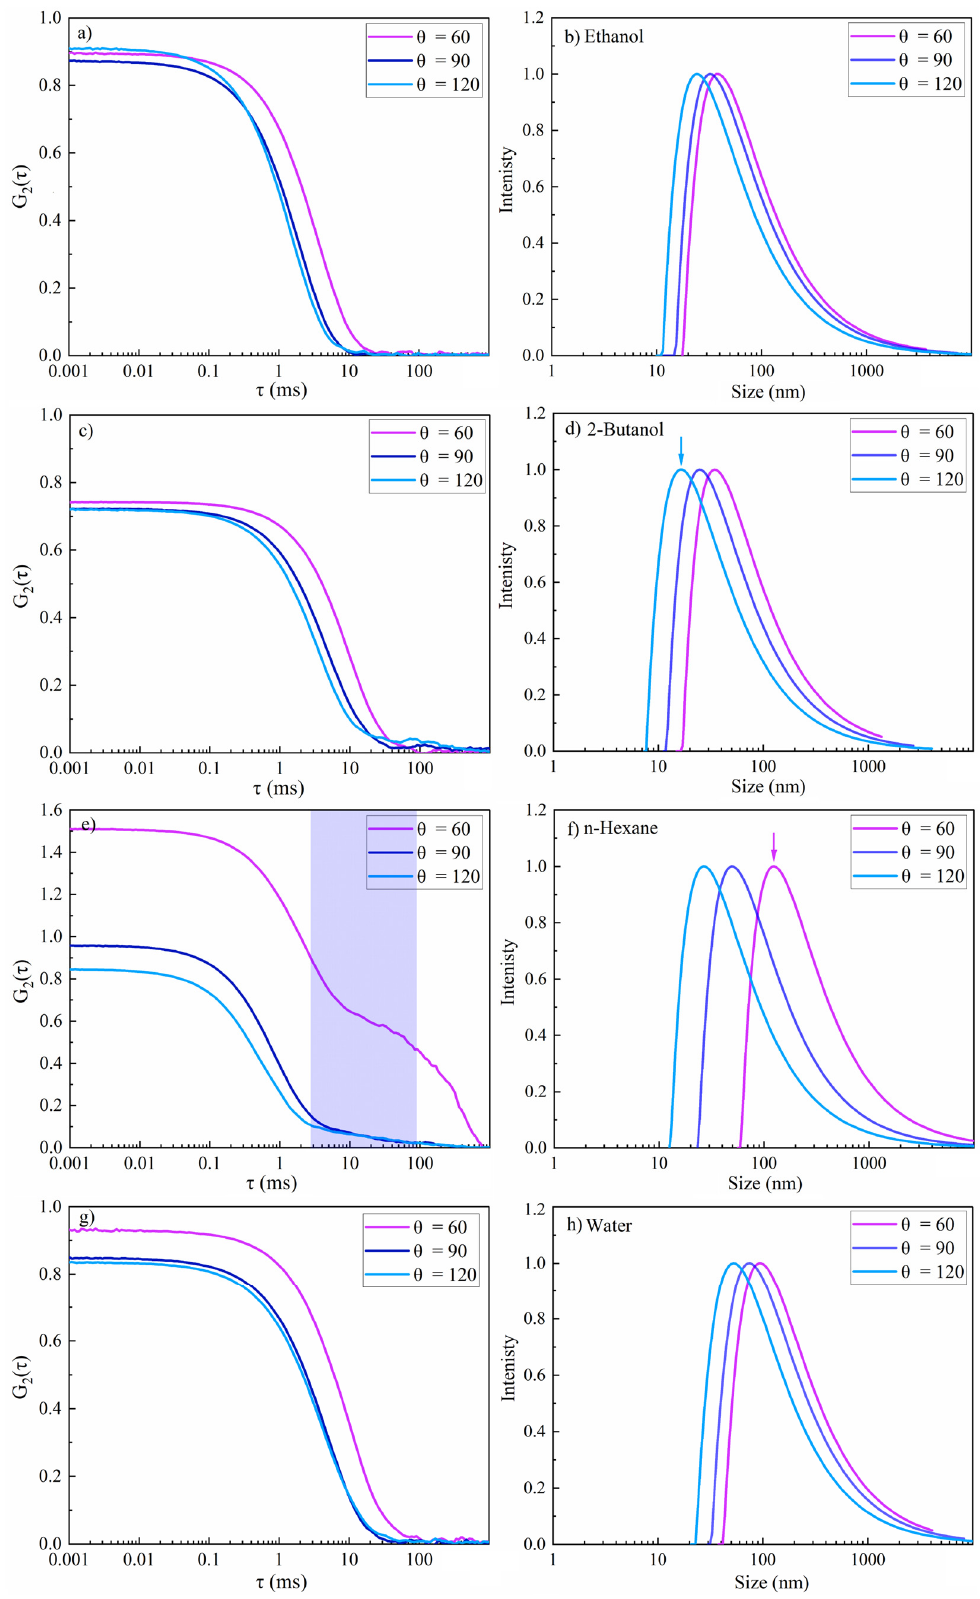
Figure 10. Multi ‐ angle dynamic light scattering of femtosecond ‐ laser ‐ synthesized colloidal nanoparticles in various fluids ( N = 1000, 1 kHz, E = 250 μ J). ( a , c , e , g ) The autocorrelation function of the intensity versus delay time ( τ ) and ( b , d , f , h ) the intensity ‐ weighted size distribution results. ( a , b ): Ethanol; ( c , d ): 2 ‐ butanol; ( e , f ): n ‐ hexane; and ( g , h ): water.